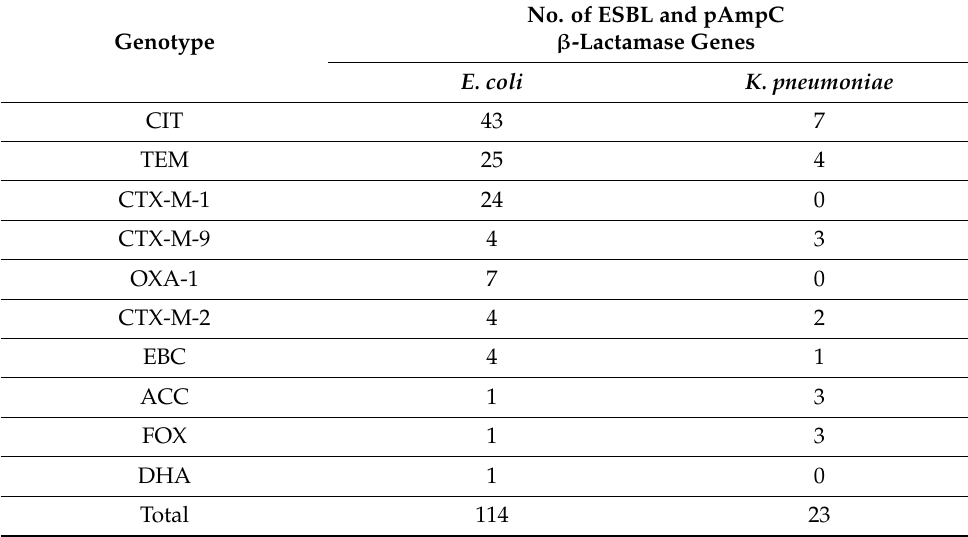
Table 5. Distribution of ESBL and pAmpC β -lactamase genes in ESBL- and pAmpC β -lactamase- producing E. coli and K. pneumoniae isolates from dogs and